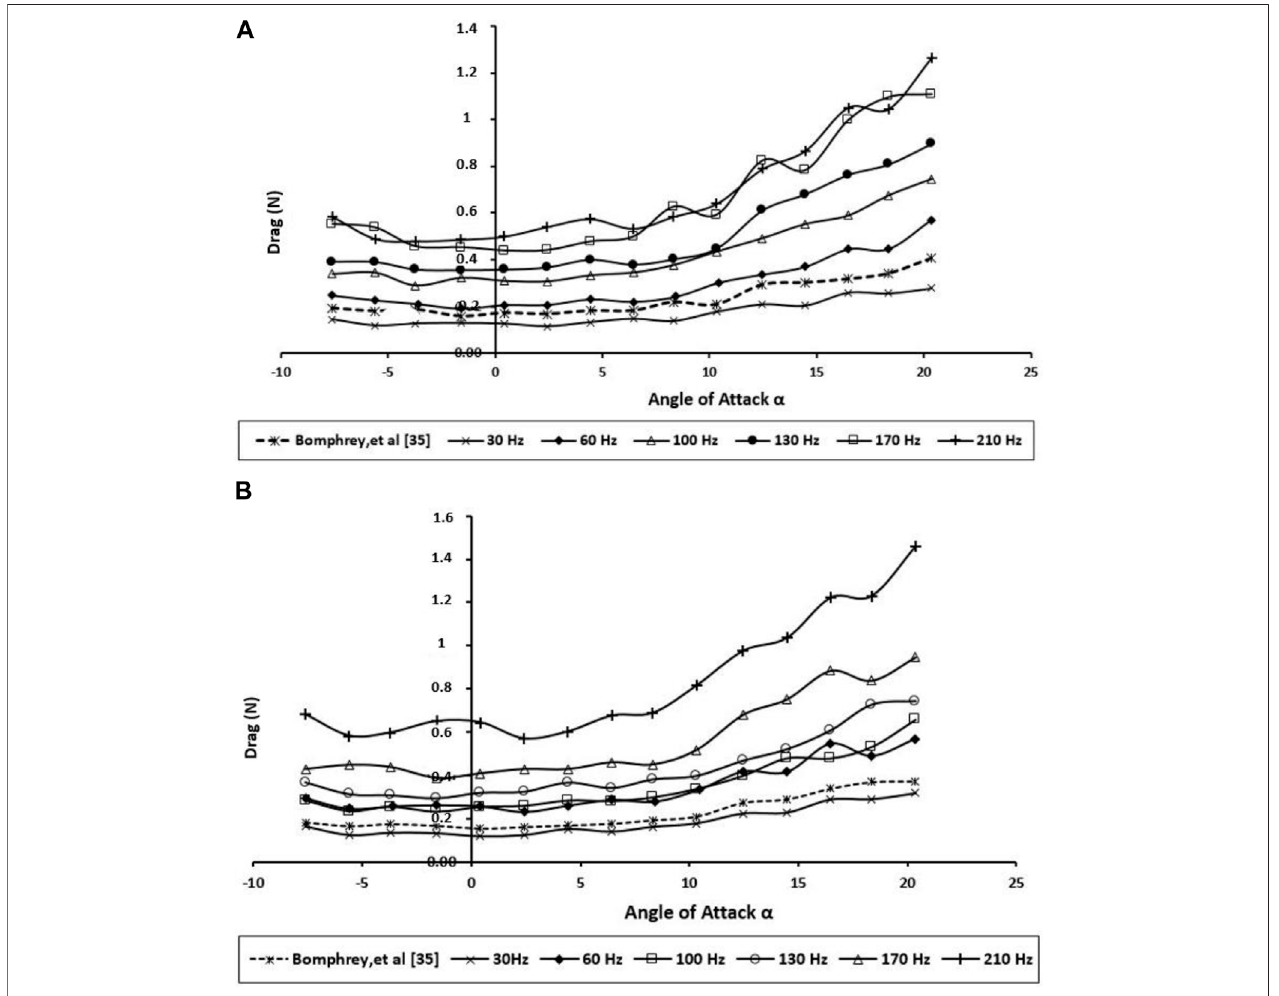
FIGURE 9 | Produced drag for the BMAV ’ s wing at various angles of attack and wing beat frequencies; (A) forewing; (B) hindwing.